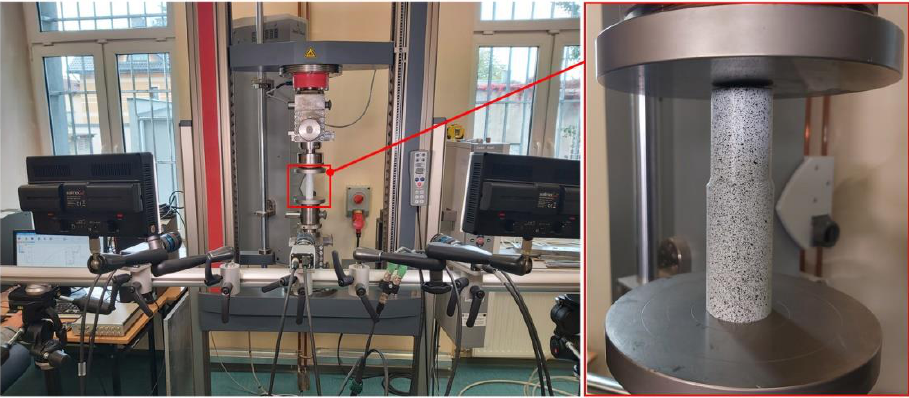
Figure 5. Measurement system for determination of displacements with working area and sample.